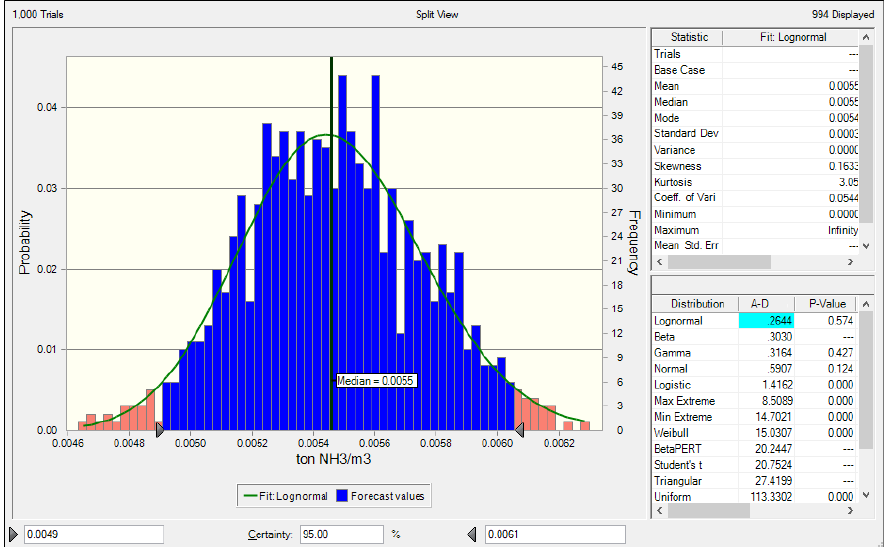
Figure 5. Uncertainty of the NH 3 emission factor at the LNG stack.